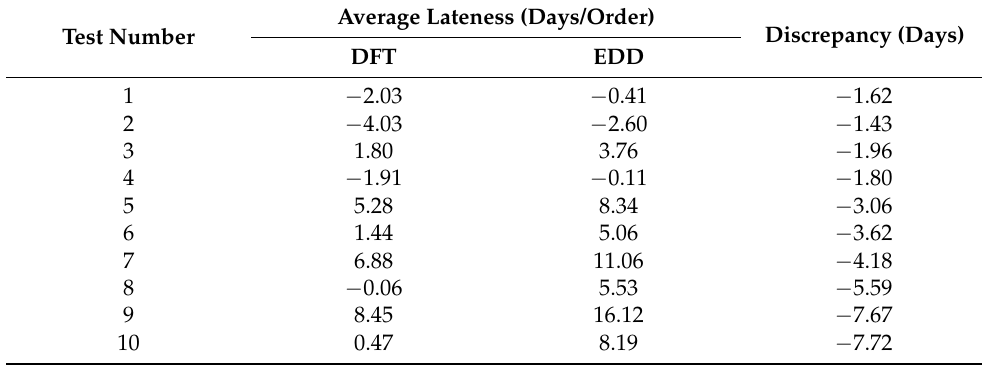
Table A14. Comparative analysis between DFT and EDD in terms of average lateness.